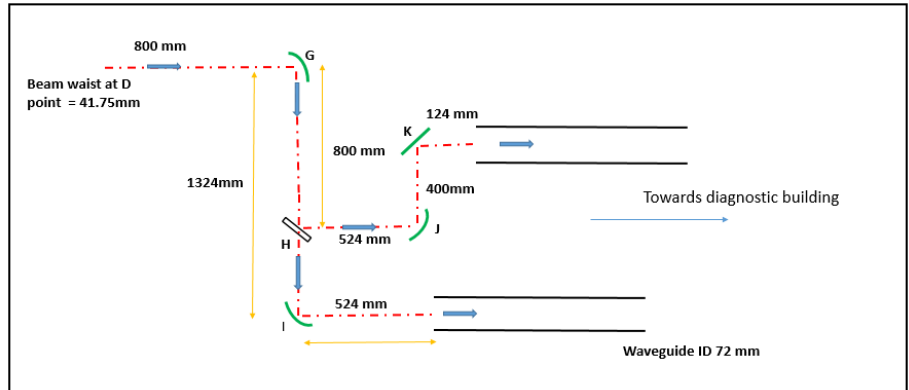
Figure 2: Optical layout of the Polarization Splitter